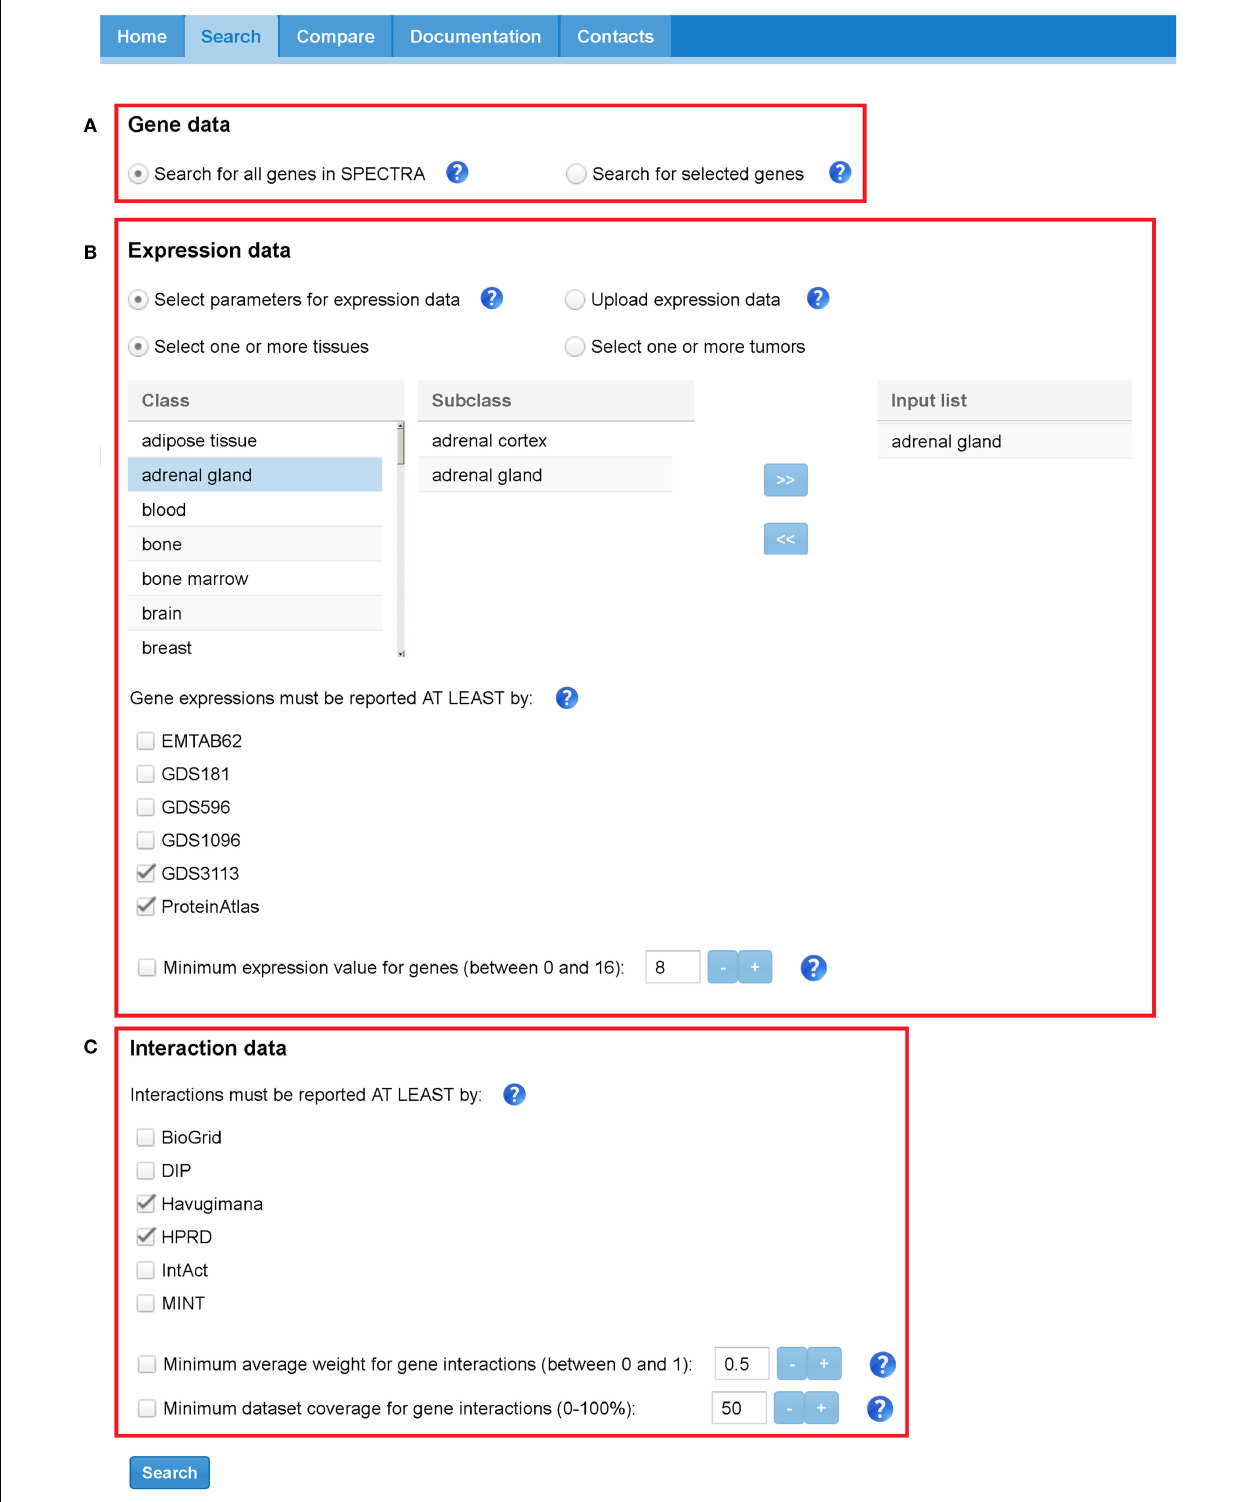
genes that are expressed in adrenal gland” tissue according at least to GDS3113 and ProteinAtlas. In this example, we neither restrict our search to a predefined set of genes nor provide a threshold for interaction weights, dataset coverage, and expression scores.